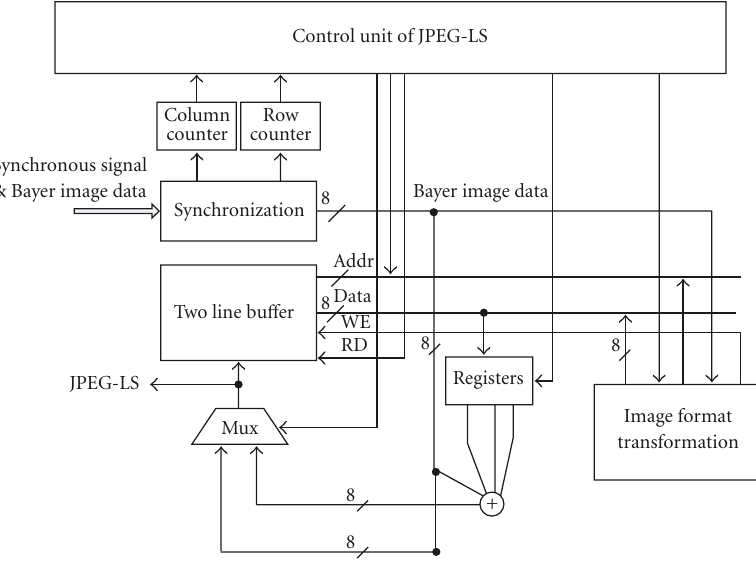
Figure 13: The VLSI architecture of the preprocessing